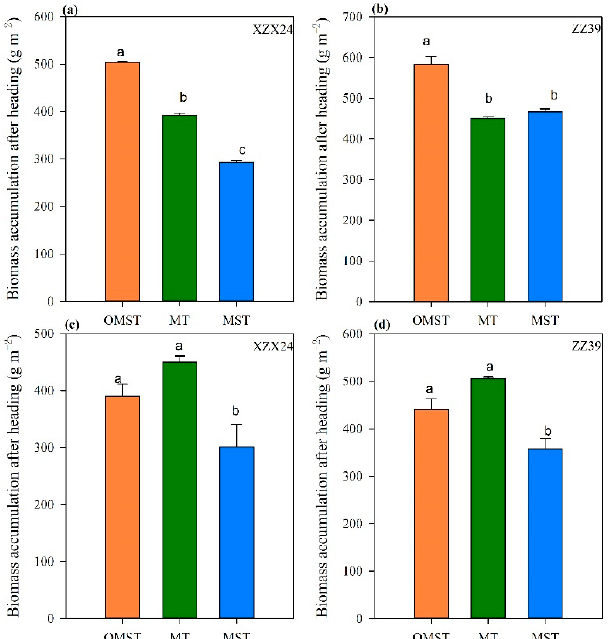
Figure 6. The biomass accumulation after heading under different rice establishment methods: ( a , b ) 2021; and ( c , d ) 2022. OMST: Orderly mechanical seedling throwing, MT: Manual transplanting, MST: Manual seedling throwing, XZX24: Xiangzaoxian24, ZZ39: Zhongzao39. Different lowercase letters denote statistical differences among treatments of a cultivar at the 5% level according to LSD test. Error bars above mean indicate standard error ( n = 3).